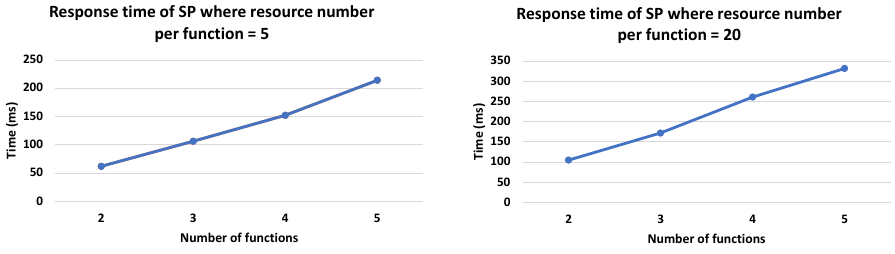
Figure 10. Response time (in ms) of SP while varying resource number per function and the number of required